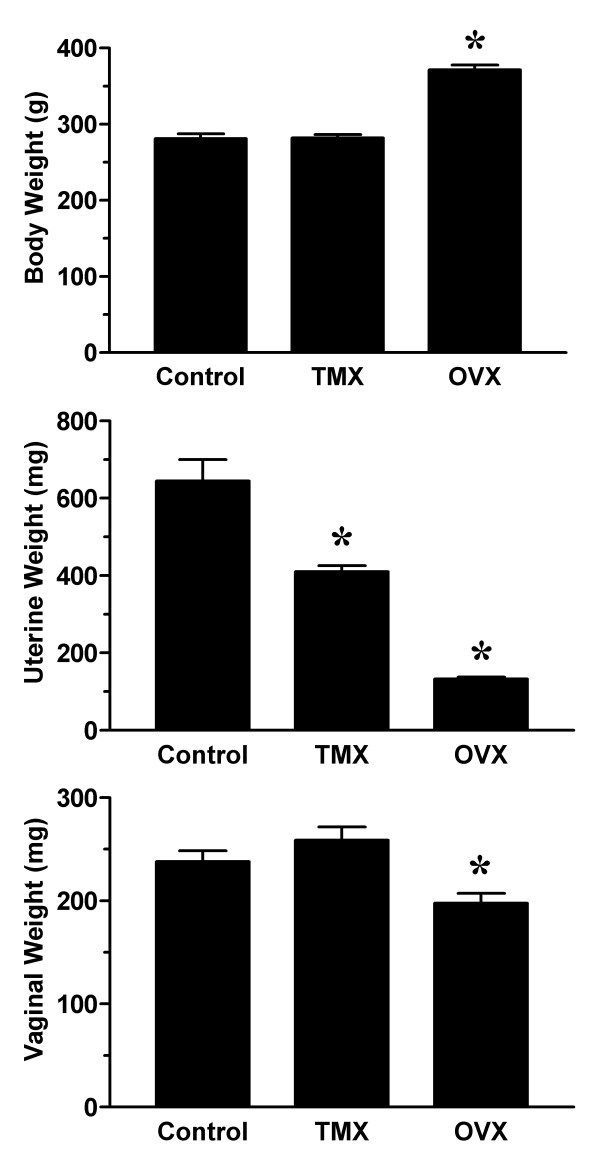
Effect of tamoxifen on body and tissue weights. Body weights were determined on the same day as vaginal blood flow studies in control (CONT), tamoxifen-infused (TMX) and ovariectomized (OVX) female rats (see Figure 1). Uterine and vaginal tissue wet weights were determined immediately following the blood flow studies. Data are the mean ± SEM and were analyzed by one-way ANOVA. *p < 0.05 versus control group.